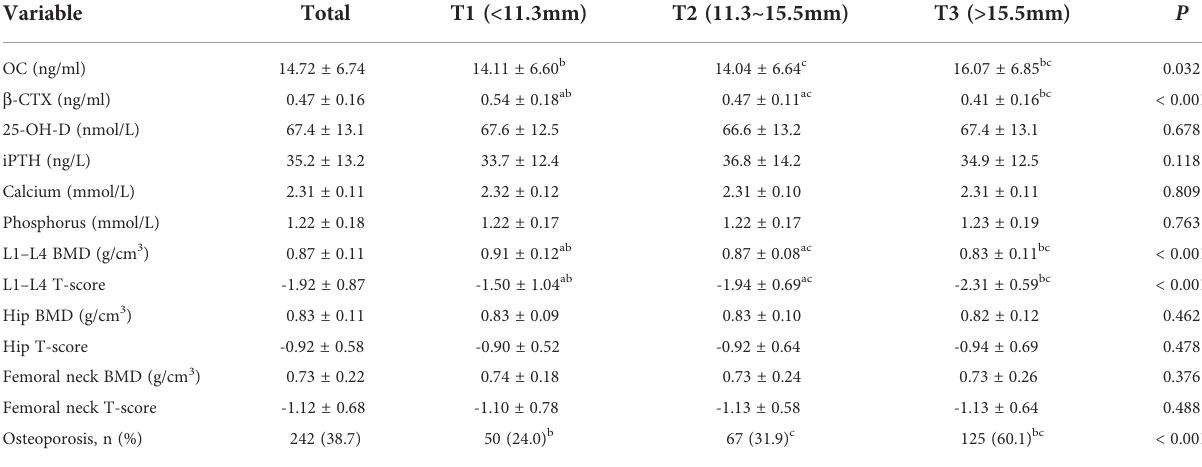
TABLE 2 BTMs and BMD of participants based on tertiles of PrFT.